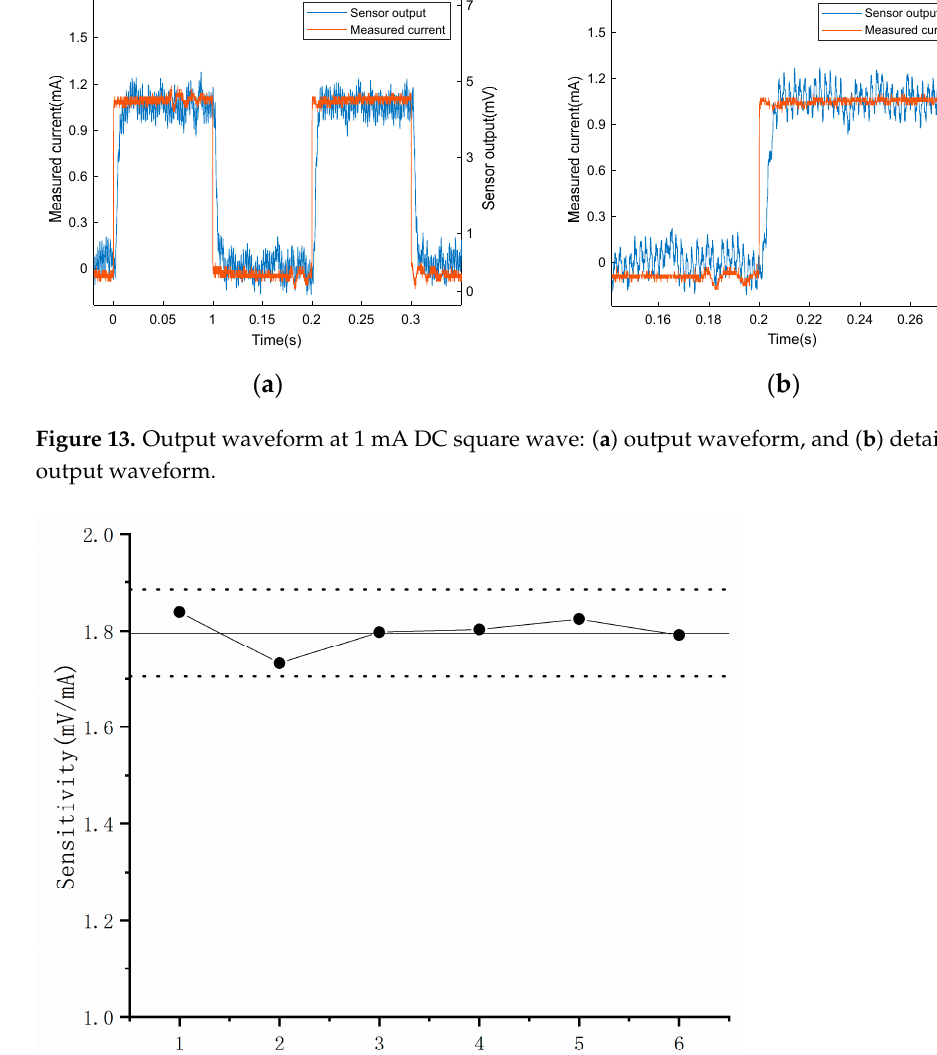
( f ) Figure 12. Output waveform at different currents: ( a ) 1 mA; ( b ) 2 mA; ( c ) 3 mA; ( d ) 4 mA; ( e ) 5 mA; and ( f ) 6 mA. As can be seen from the figure, the designed sensor can measure the mA level current very well. As the current amplitude increases, the output voltage trace becomes clearer, and the noise causes less impact on the sensor. The absolute value of the error of the out-